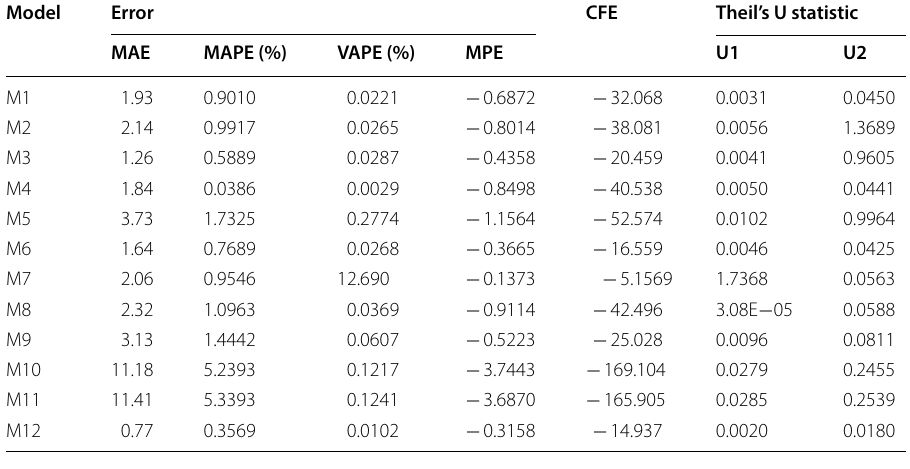
Table 4 Statistical indices of different models